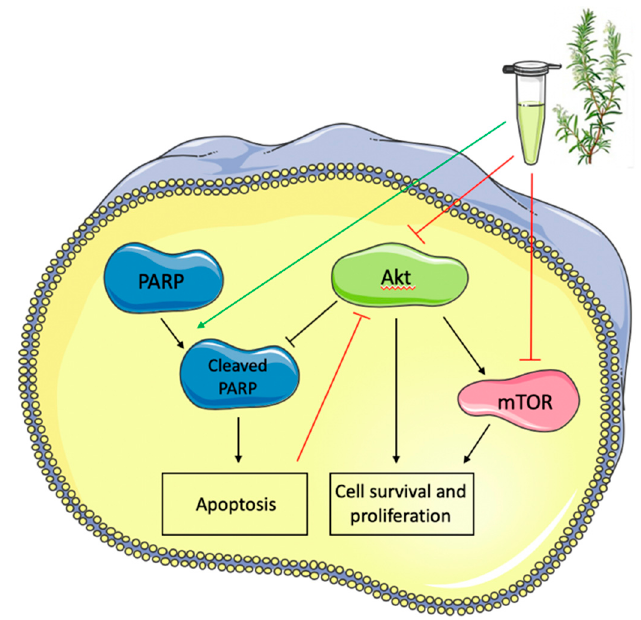
Figure 8. Effects of rosemary extract on MDA-MB-231 triple-negative breast cancer cell signaling molecules. RE inhibited the phosphorylation/activation and total levels of Akt and mTOR, while it enhanced the levels of cleaved PARP.